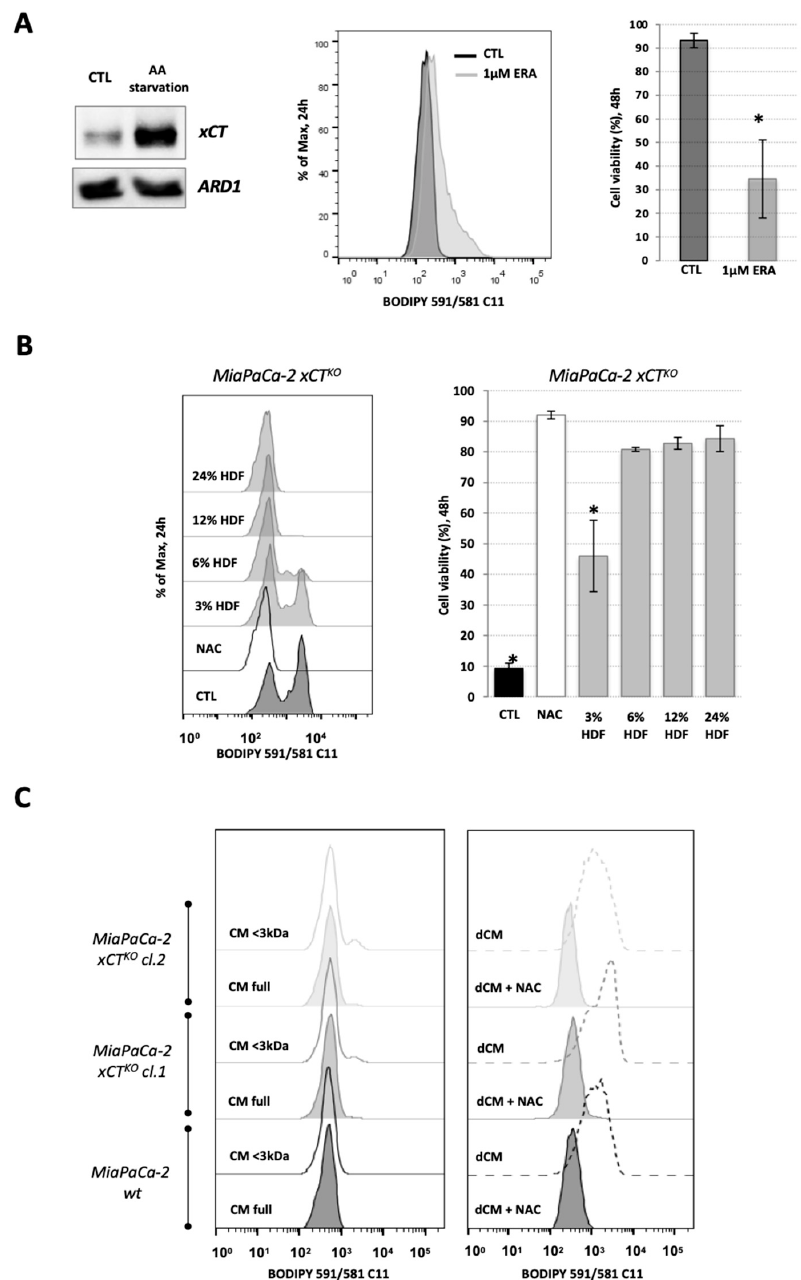
Figure 1. Fibroblasts reverse the characteristic ferroptosis phenotype of pancreatic ductal adenocar- cinoma (PDAC) xCT KO cells. ( A ). The expression level of xCT in human dermal fibroblasts (HDF) under basal and amino acid (AA) starvation conditions (Western blot, left panel—ARD1 used as loading control), their sensitivity to xCT inhibition by erastin (ERA) seen through the lipid hydroper- oxide accumulation after 24 h (BODIPY 591/581 C11 staining, middle panel), i.e., cell viability after 48 h (right bar graph). ( B ) . Optimization of the co-culture conditions: accumulation of the lipid hydroperoxides (left) and cell viability (right) of MiaPaCa-2 xCT KO cells co-cultured with 3%, 6%, 12% or 25%, of HDF cells during 24 h and 48 h, respectively. ( C ) . BODIPY 591/581 C11 staining of MiaPaCa-2 wild type (wt) and xCT KO cells cultured for 24 h in full or fractionated (lower (<) or higher (>) then 3 kDa, left and right panel, respectively) conditional media (CM) of HDF; dCM = dialyzed conditional media (>3 kDa). All experiments have been performed in triplicate and the representative blots and histograms are shown. Bar graphs show mean ± SEM; n = 3; *, p < 0.05, comparison with control